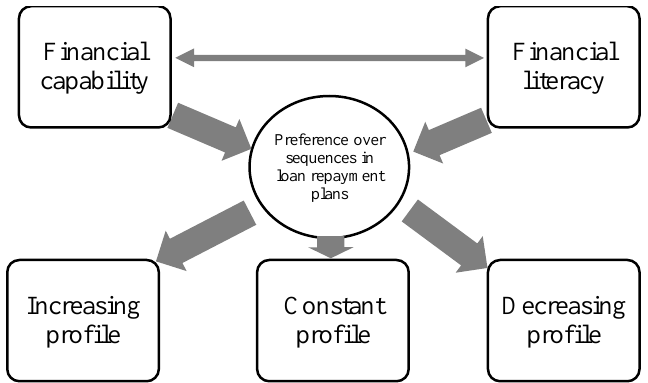
Figure 1 . Relationship between variables #1 and #3 and the three considered profiles: decreasing, constant and